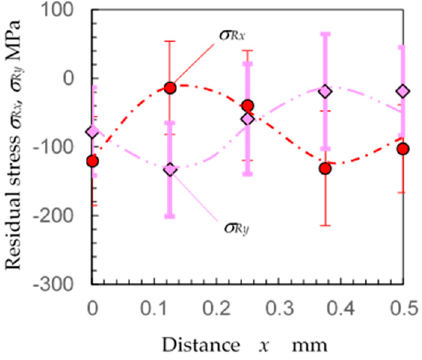
Figure 16. Distribution of the residual stress changing with distance y at various positions of x (specimen D); ( a ) residual stress in the x -direction σ Rx ; ( b ) residual stress in the y -direction σ Ry . Figure 17 reveals the residual stress σ Rx and σ Ry changing with distance x at y = 0 with the laser spot aligned in the x -direction. The σ Rx was about − 100 MPa at x = 0 mm; it had a